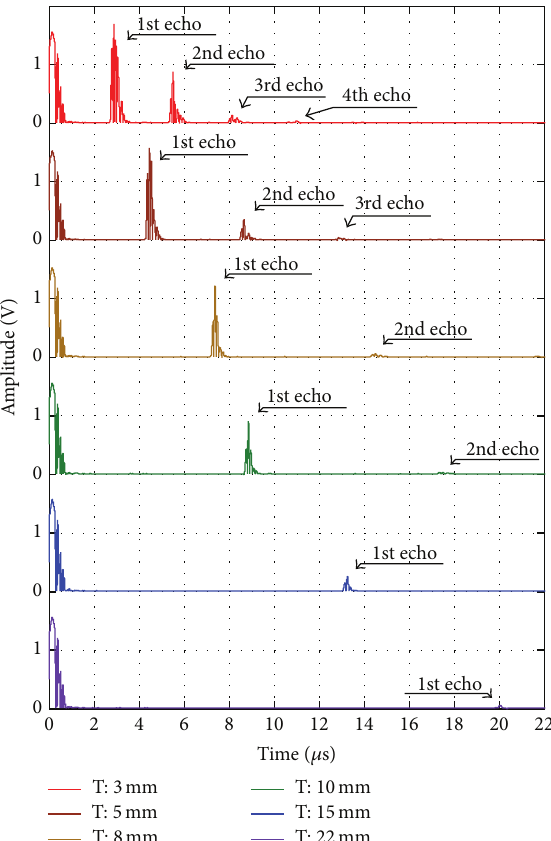
Figure 7: Reflected waves in PVC sheets of different thickness (gain: 0 dB).